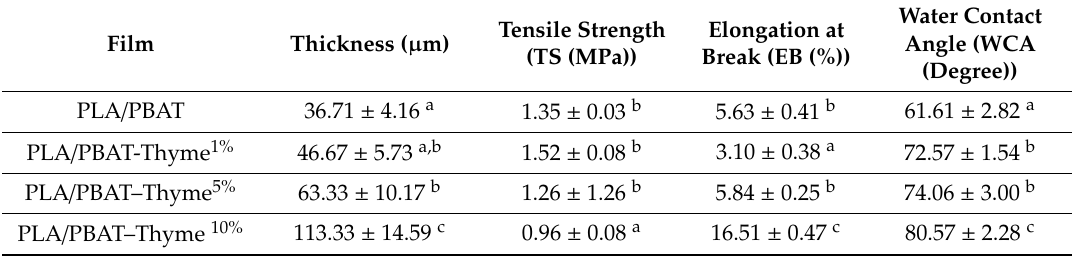
Table 3. Thickness, tensile properties and hydrophobicity of the thyme oil composite films.